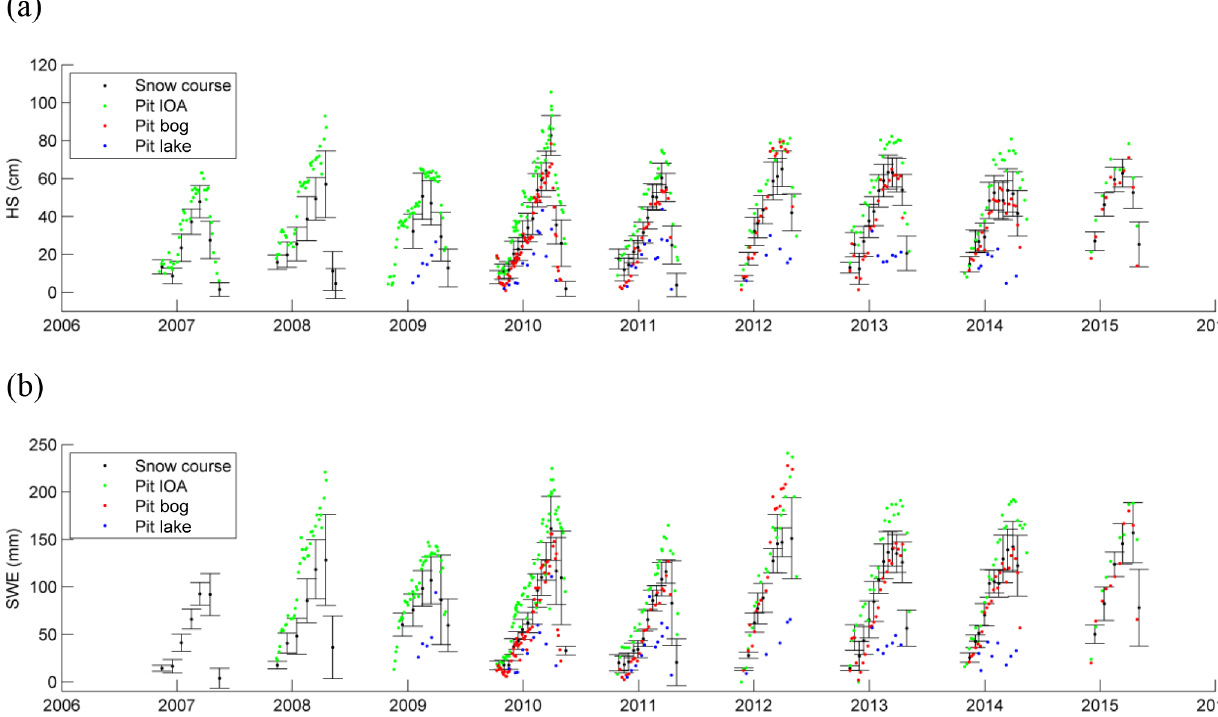
Figure 6. Time series of (a) HS and (b) SWE measurements from 2006 to 2016 from the Sodankylä snow course and from the three snow pit sites. Mean values of all measurements from the snow course with error bars of standard deviation are shown. For snow pits, the mean of three measurements is